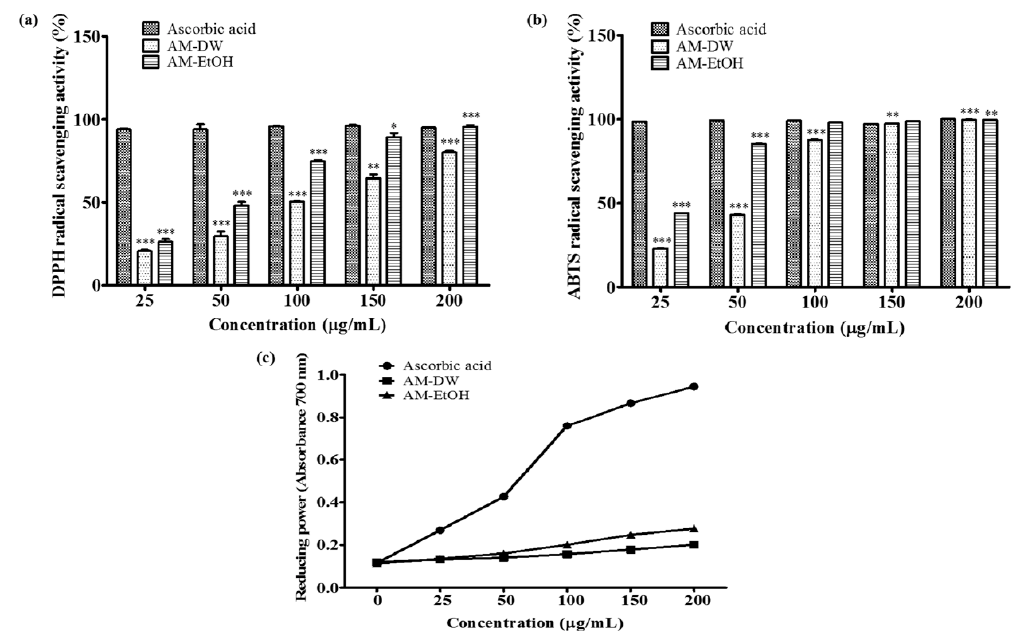
Figure 2. Antioxidant activity of AM extracts. ( a ) DPPH radical scavenging activity of AM extracts; ( b ) ABTS radical scavenging activity of AM extracts. The values are the mean ± S.D. from three independent experiments * p < 0.05, ** p < 0.01, *** p < 0.001 vs. control group. Ascorbic acid used as control; ( c ) Reducing power activity of Aronia melanocarpa ‘Viking’ extracts. The data are express as median ± standard deviation ( n = 3).